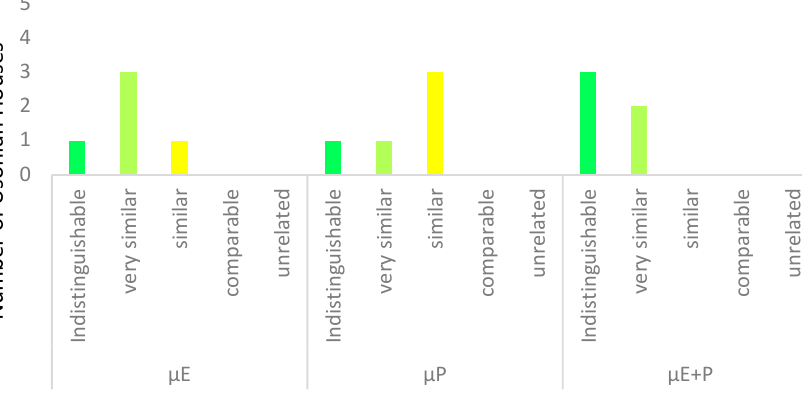
Figure 14. Qualitative comparison of Usonian houses and Fallingwater. The Usonian set is the most related to Fallingwater in terms of their visual complexity. Unlike the other two styles, none of the houses in the Usonian set are either ‘comparable’ or ‘unrelated’ to Fallingwater . Three of the houses are effectively ‘indistinguishable’ in their composite result, the Chahroudi House being the closest to Fallingwater for this set ( R μ E+P% = 0.9540). Two of the Usonian houses have the least difference to Fallingwater of all the fifteen houses tested; the Reisley House elevations are ‘indistinguishable’ to those of Fallingwater ( R μ E% = 0.3750) and the Fawcett House is ‘very similar’ in plan ( R μ P% = 0.8800), more so than any of the other 14 houses. From the data presented in this section and the previous one, a profile is generated of Fallingwater in comparison to Wright’s other houses under study (Figure 15). This shows the complexity of the styles and of Fallingwater ranked according to mean D on the y –axis and then a bar indicating the mean range of each style from Fallingwater along the x –axis. This bar graph is determined by loading the occasions of ‘indistinguishable’ to ‘unrelated’ (extracted from Table 2) with numerical weight from 0–4. ‘Indistinguishable’ suggests little difference from Fallingwater (0)—the lower the result, the shorter the bar, and the more similar the style could be described as being to Fallingwater .